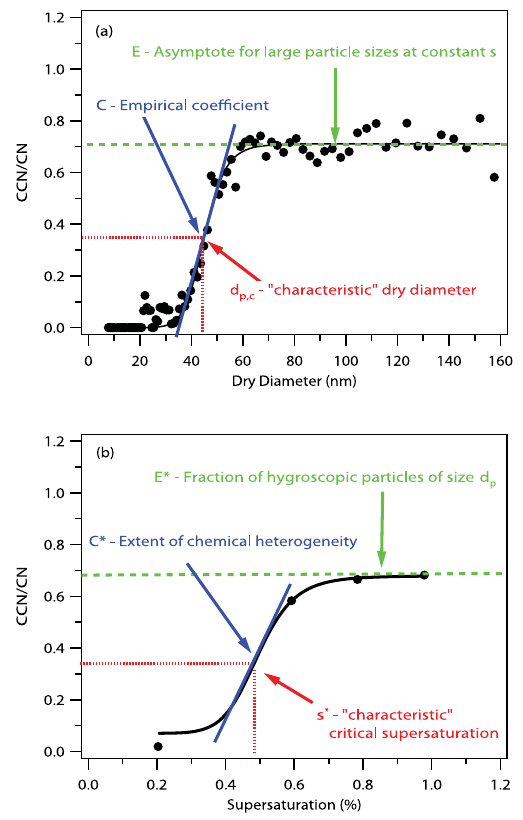
Fig. 4. (a) Example of the CCN-to-CN activation ratio as a function of dry diameter (for s = 0 . 98% on 2 August 2008 at 01:30 a.m.) with sigmoid fit and its defined parameters. (b) Example of CCN- to-CN activation ratio as a function of supersaturation for a 80nm dry particle (sample collected on 14 August 2008 at 01:00p.m.) as derived from the SMCA with sigmoid fit and its defined